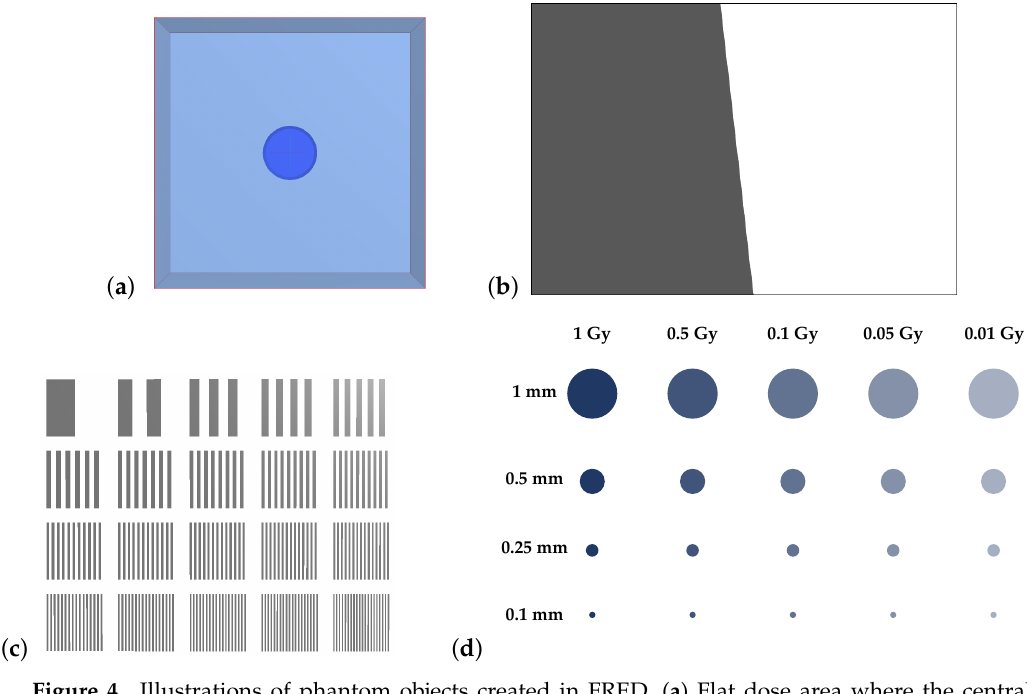
Figure 4. Illustrations of phantom objects created in FRED. ( a ) Flat dose area where the central cylinder represents 20 ◦ C water after absorbing a dose of 1 Gy. ( b ) Attenuating slanted edge for modulation-transfer function (MTF) analysis. ( c ) Fencepost phantom with areas ranging from 1 to 20 lp/mm. ( d ) Contrast-detail phantom with a range of volumes arranged in a grid according to their doses (columns) and diameters